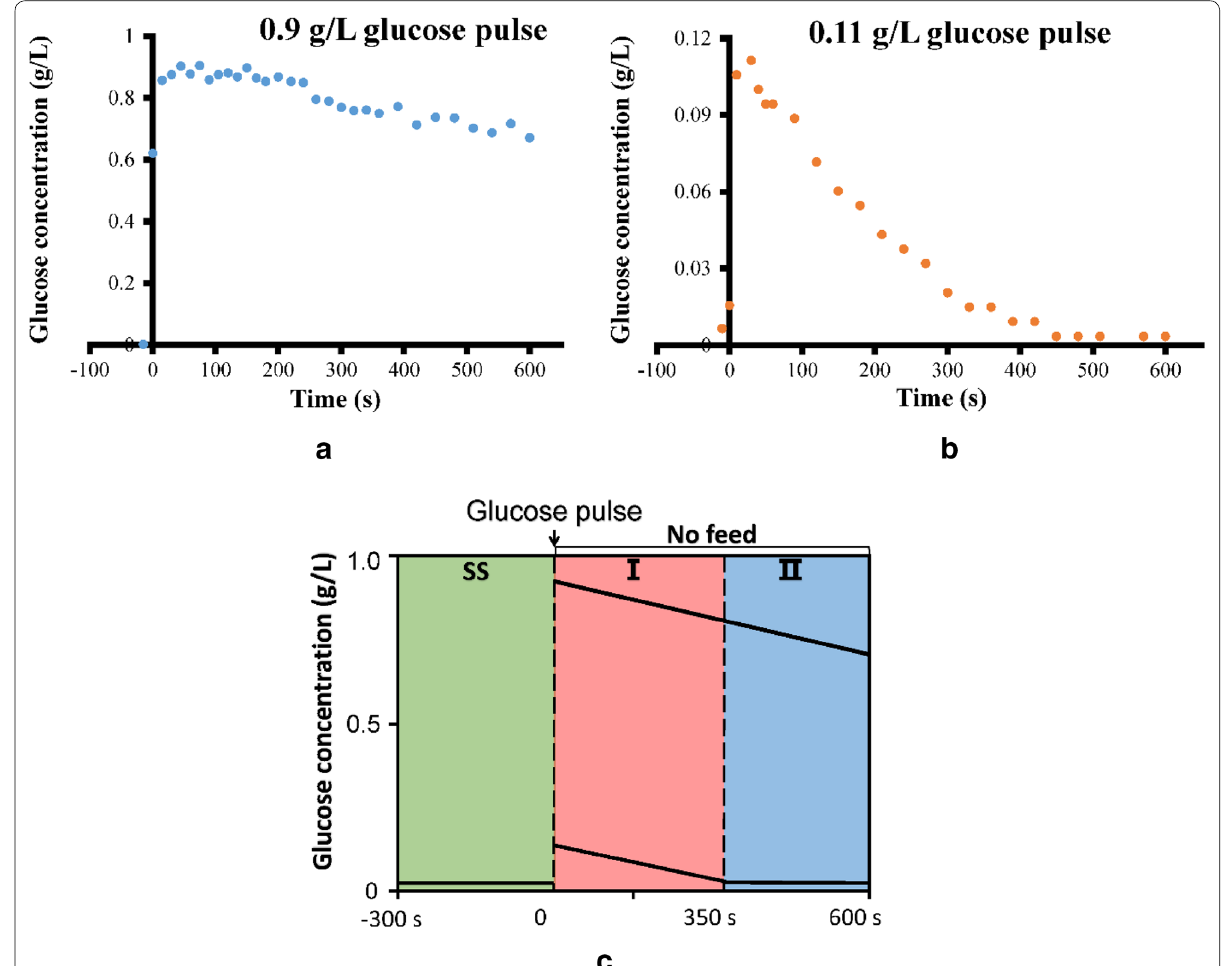
Fig. 2 Extracellular glucose concentration profiles in the first 10 min after the glucose pulses. a High glucose concentration (3.00 g glucose addition via a syringe containing concentrated glucose concentration); b low glucose concentration (0.34 g glucose); c phasing scheme of the glucose pulse experiments (SS: steady state; I: glucose-rich phase and II: glucose-depletion phase for the low glucose concentration pulse